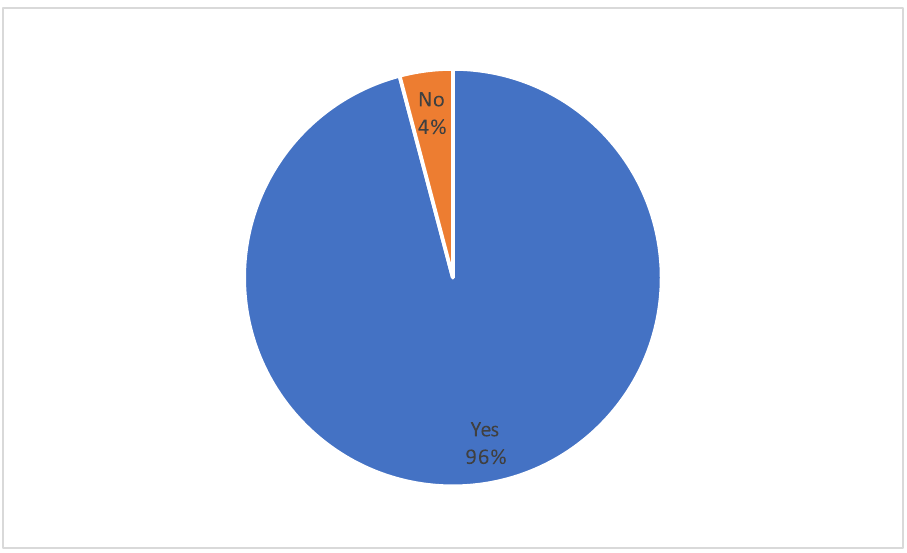
Figure 8: Importance of emerging technologies for promoting sustainable tourism at cultural heritage